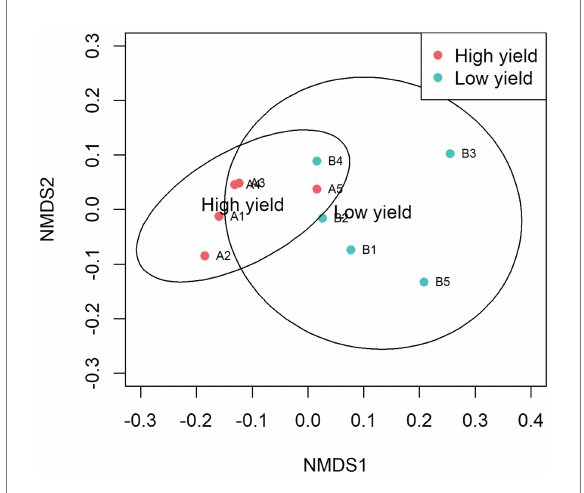
FIGURE 3 Non-metric multidimensional scaling (NMDS) of samples in group A and group B. The dissimilarity of 10 samples was calculated by Bray-Curtis and plotted with NMDS with 95% confidence interval. Samples in group A are presented as red circles and samples in group B are presented as cyan circles. The groups show significant differences in similarity analyzed by ANOSIM (pANOSIM =